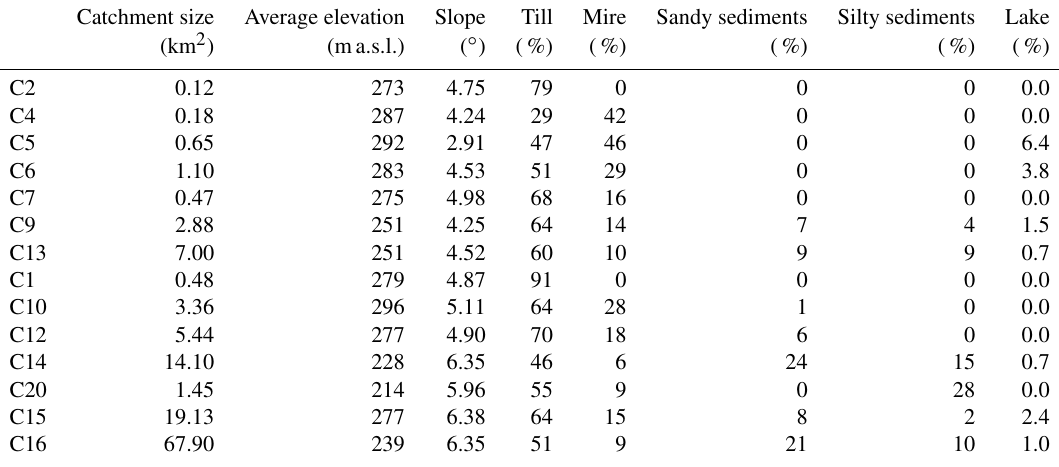
Table 1. Sub-catchment characteristics . The list includes all 14 monitored sub-catchments in Krycklan, called C1 to C20, including the entire Krycklan catchment, C16. Different branches of the stream network are gathered in the table and illustrated in distinct colours in Fig. 1. The table includes the sub-catchment area, average elevation, and average slope. Further descriptions of these characteristics can be found in Karlsen et al. (2016). The table also includes soil proportion based on the soil map (1 : 100000) from the Swedish Geological Survey (2016).